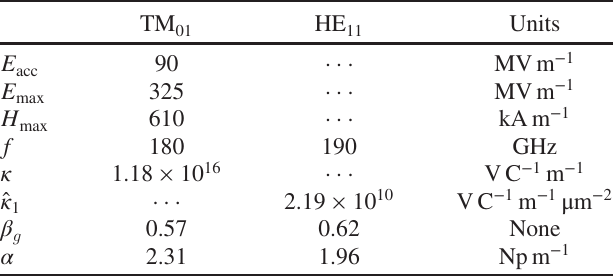
TABLE I. A-STAR CWG operating parameters.